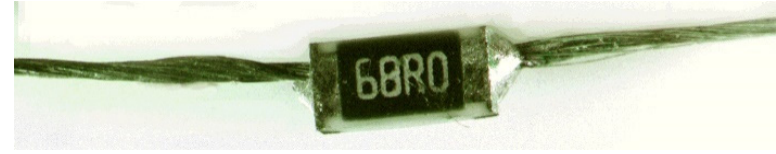
Figure 4. SMD integrated E-yarn.